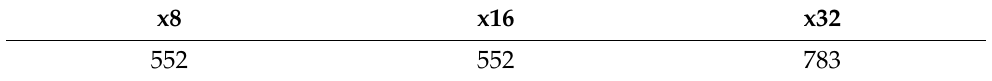
Table 5. Number of estimated models per microstepping signal, dependent only on signal